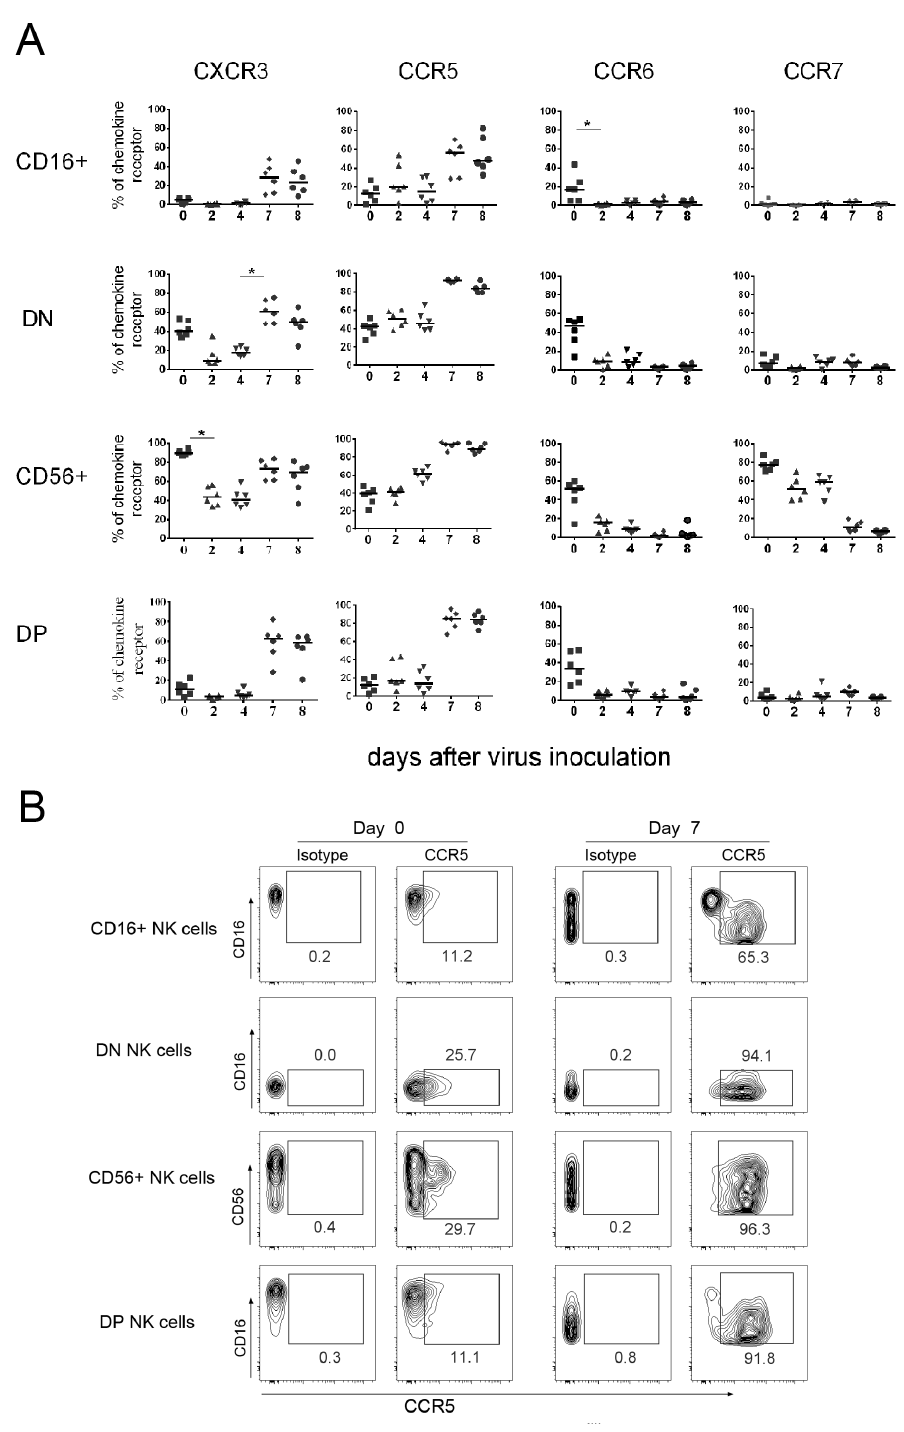
Figure 4. MPXV infection induced changes in the expression of chemokine receptors on blood NK cells. PBMCs from different time points following MPXV inoculation were stained for NK markers and chemokine receptors as described in the material and methods. The chemokine receptor expression was revealed by gating on individual NK cell subsets. A) Expression kinetics of CXCR3, CCR5, CCR6, and CCR7 on NK cell subsets following MPXV inoculation. B) Representative analysis of CCR5 expression on NK cells at days 0 and day 7 post-inoculation. Statistical analyses were permutation re-sampling tests with Holm-adjusted p- values computed using R (*p<0.05). doi: 10.1371/journal.pone.0077804.g004 PLOS ONE |